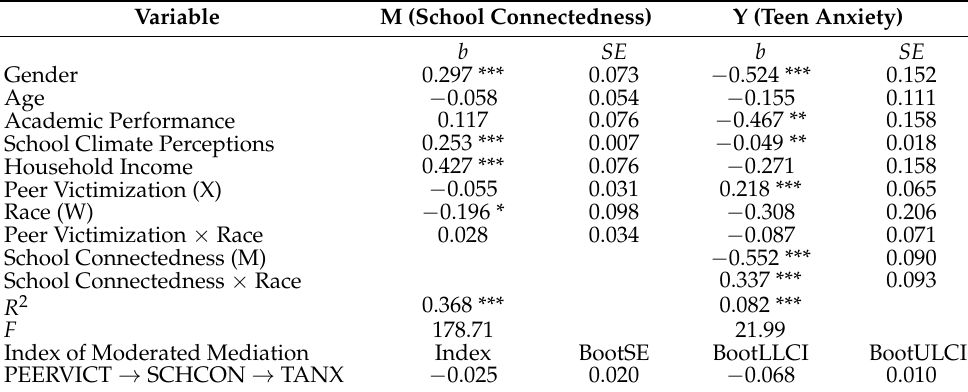
Figure 7. Moderation effect of race in the relationship between peer victimization and teen anxiety. Table 3. Testing the moderated mediation effect of peer victimization on teen anxiety ( n =